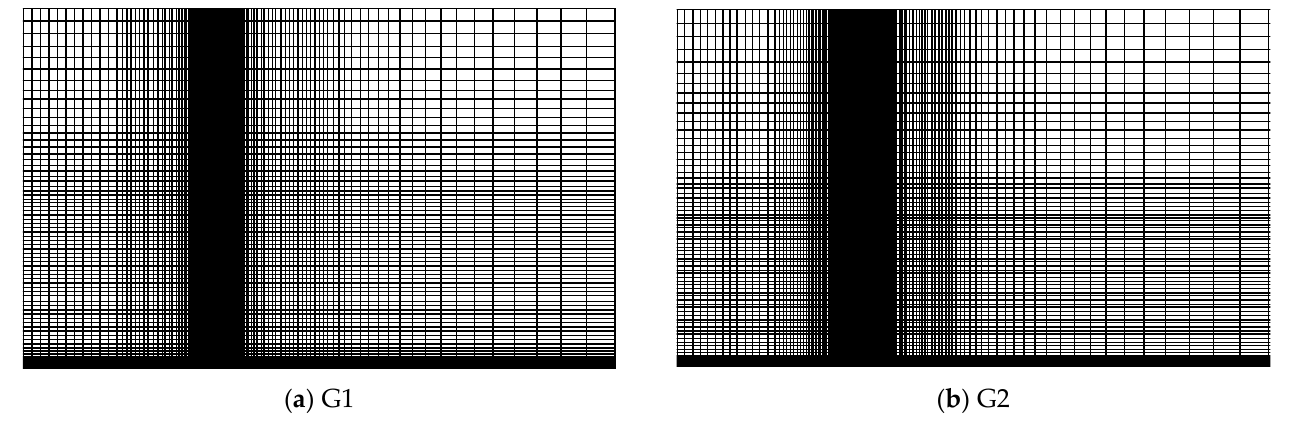
Figure 8. Computational grids for the empty domain.